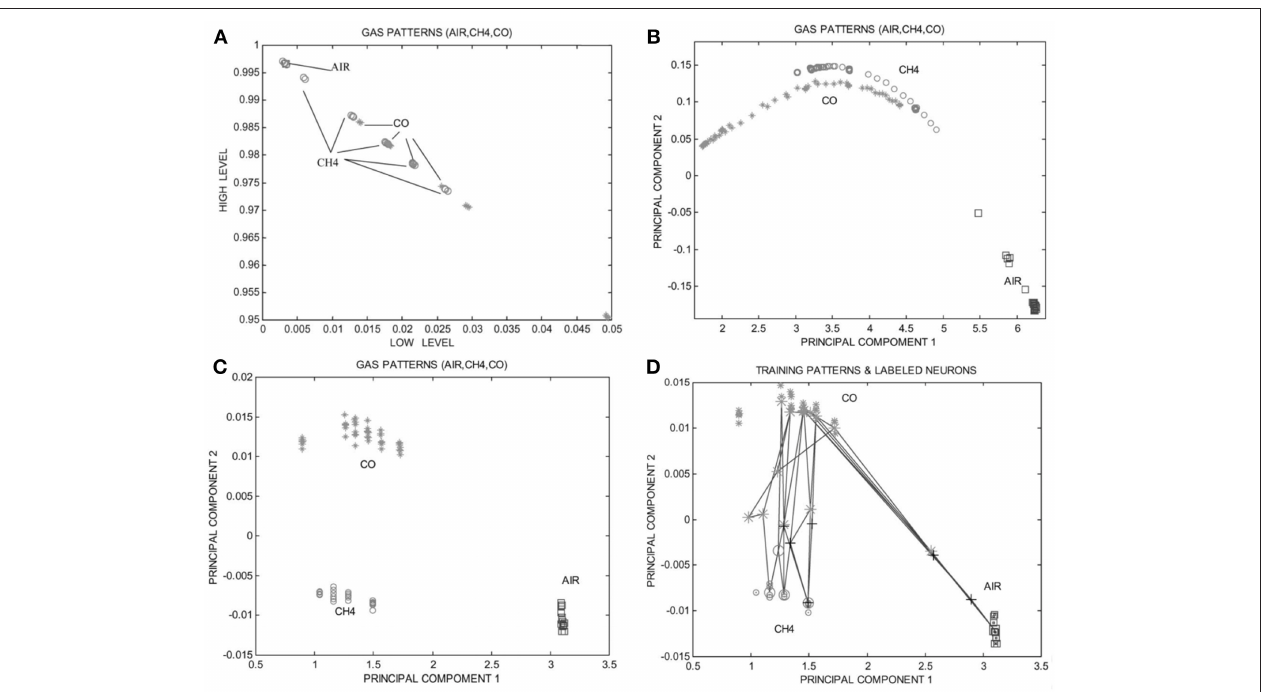
FIGURE 15 | (A) Static measurement to CH 4 , CO, and air based on single sensor. (B) The projected image of gas patterns obtained from the output of one sensor heated with a triangular waveform. (C) The projected image of gas patterns obtained from FFT processing of the high temperature portion of the pulse heating waveform. (D) The projected image of SOM sub-nets and gas patterns, where three supervised SOM sub-nets are plotted. Reprinted with permission from Ortega et al. (2001), copyright 2001 Elsevier Science